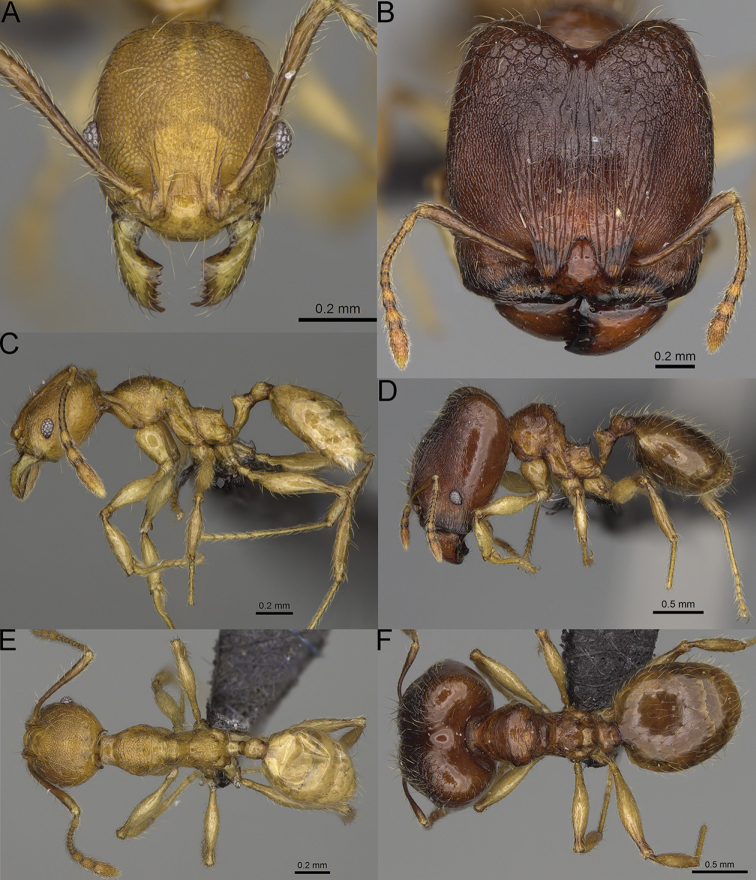
Pheidole
boribora sp. nov., full-face view (A), profile (C), and dorsal view (E) of paratype minor worker (CASENT0456014) and full-face view (B), profile (D), and dorsal view (F) of holotype major worker (CASENT0456013).